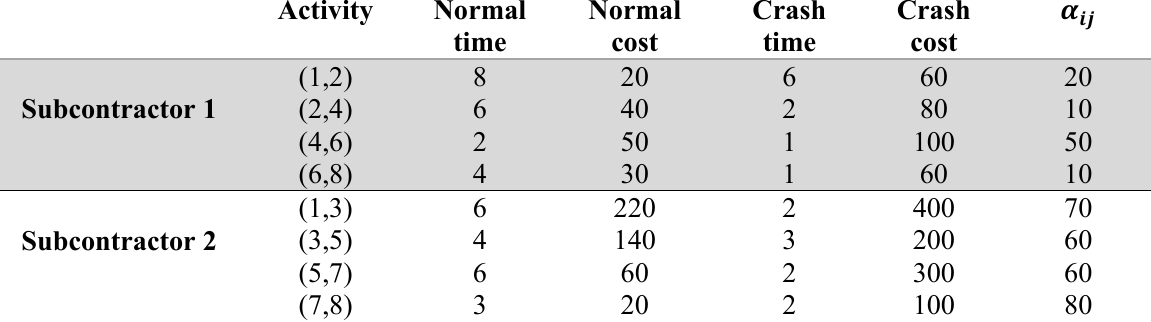
Fig. 4. Sharing penalties and rewards according to the project time for the example of this paper Network information for illustrative example with two subcontractors